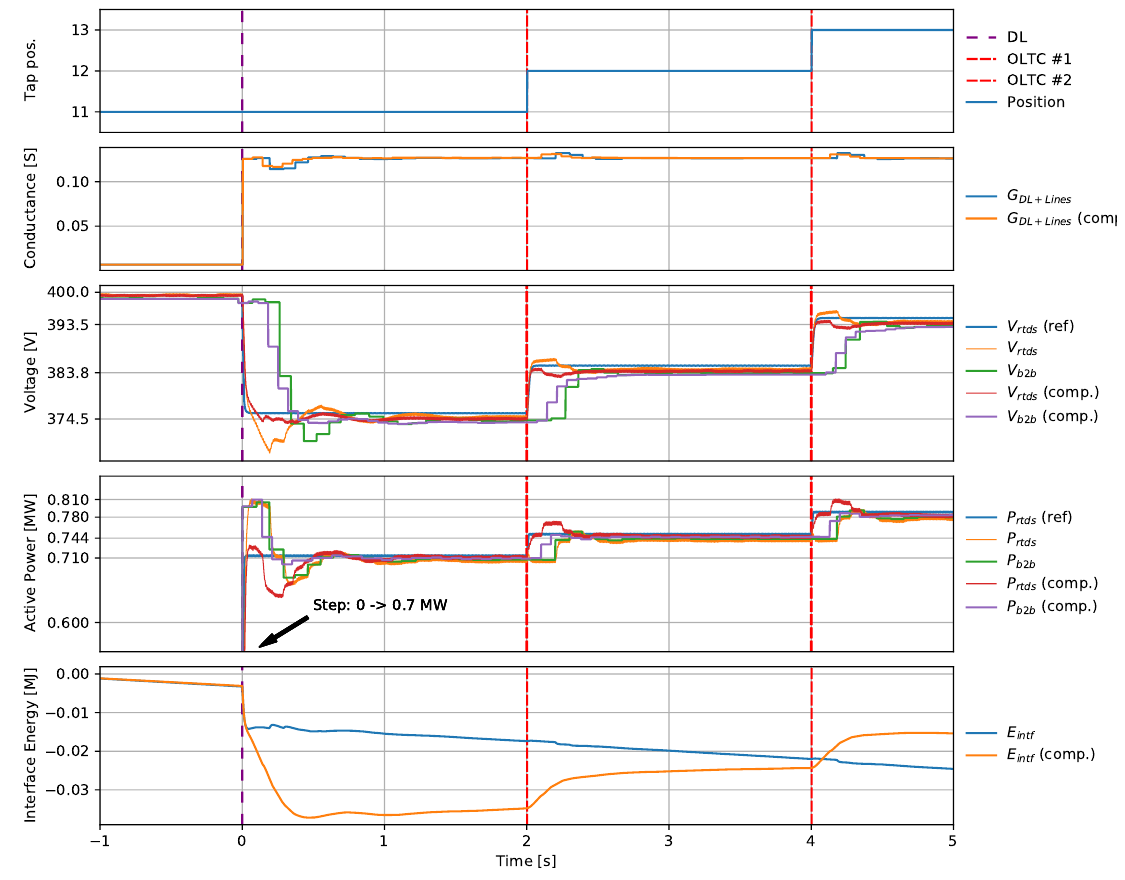
Figure A1. Closed-loop test